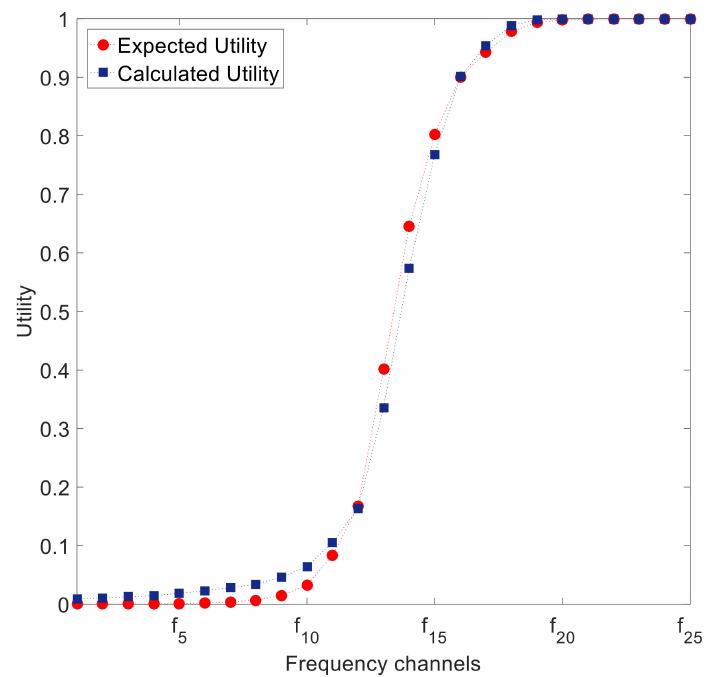
Figure 6. Experimental and calculated utilities.